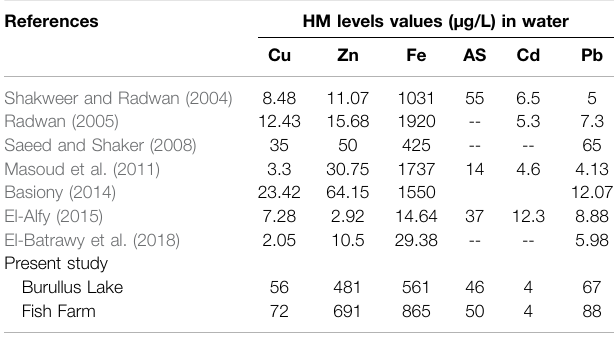
TABLE2| ComparisonbetweenHMslevelsof( μ g/L=ppb)inBurullusLakewater of the present study with the previous